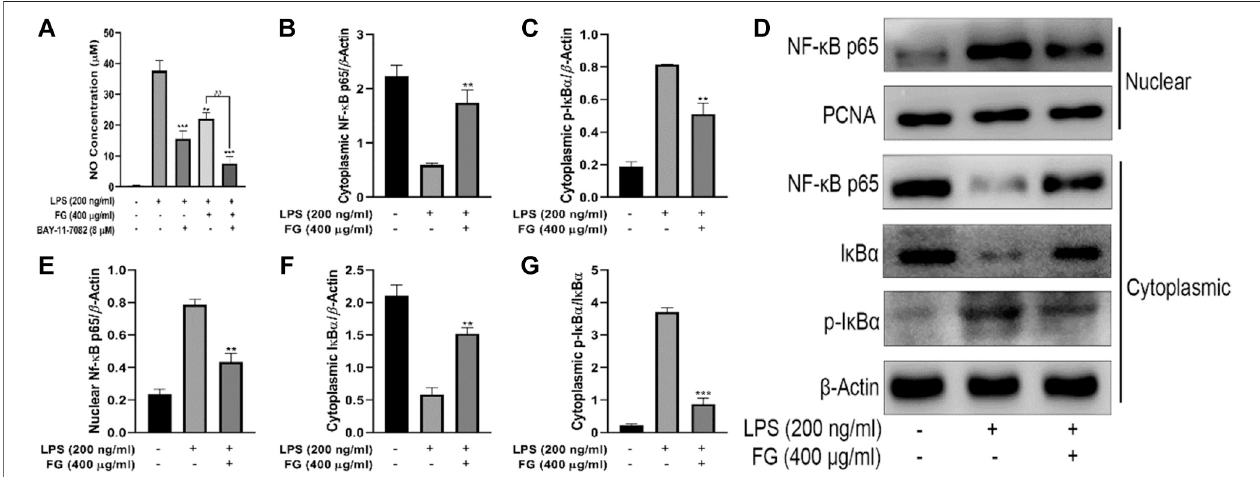
FIGURE 7| Effects of FG on the NF- κ B signaling pathway in LPS-induced BV2 microglia.BV2 cells were pretreated with BAY-11 – 7082 (8 μ M) for 2 h, followed by the treatment of FG extraction (400 μ g/ml) and LPS (200 ng/ml) for 24 h. Accumulation of NO in the cell culture supernatant was measured using a Griess assay kit (A) . Afterward, the cells were treated with FG extraction (400 μ g/ml) in the presence of LPS (200 ng/ml) for 24 h, and the nuclear and cytoplasmic protein extractions were then prepared for nuclear NF- κ B/p65 and cytoplasmic I κ B α and p-I κ B α detection by Western blot (B – G) . Results are expressed as mean ± SEM of three independent experiments ( ** p < 0.01, *** p < 0.001, ## p < 0.01).